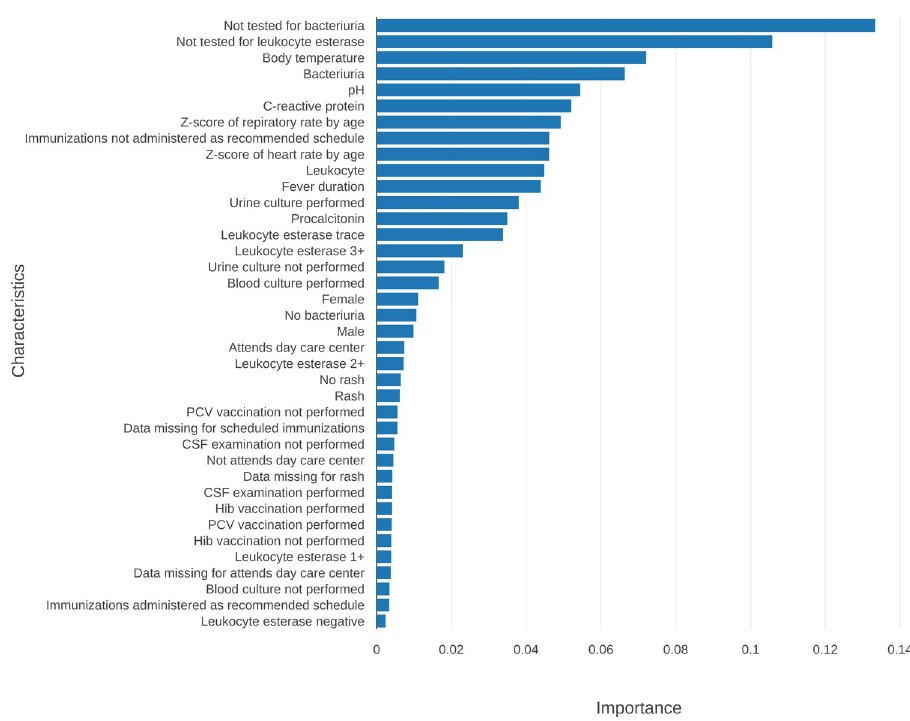
Fig 3. Feature importance of the RF model using the reduction in GINI impurity. Important factors for SBI prediction are listed in the order of importance, and the feature importance was obtained using the scikit-learn library [20]. CSF = cerebrospinal